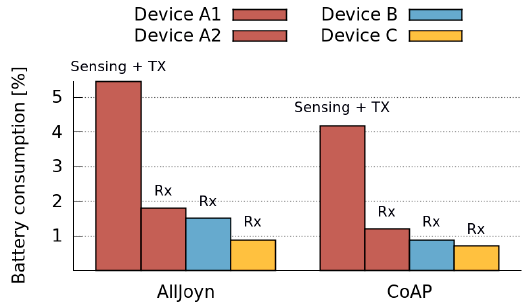
Figure 15. Comparison of the overall collaborative sensing costs of AllJoyn and CoAP for different devices.